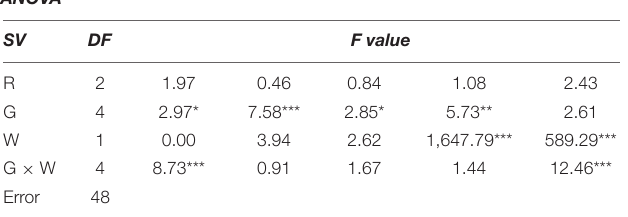
water uptake. Overall, the models showed large interindividual